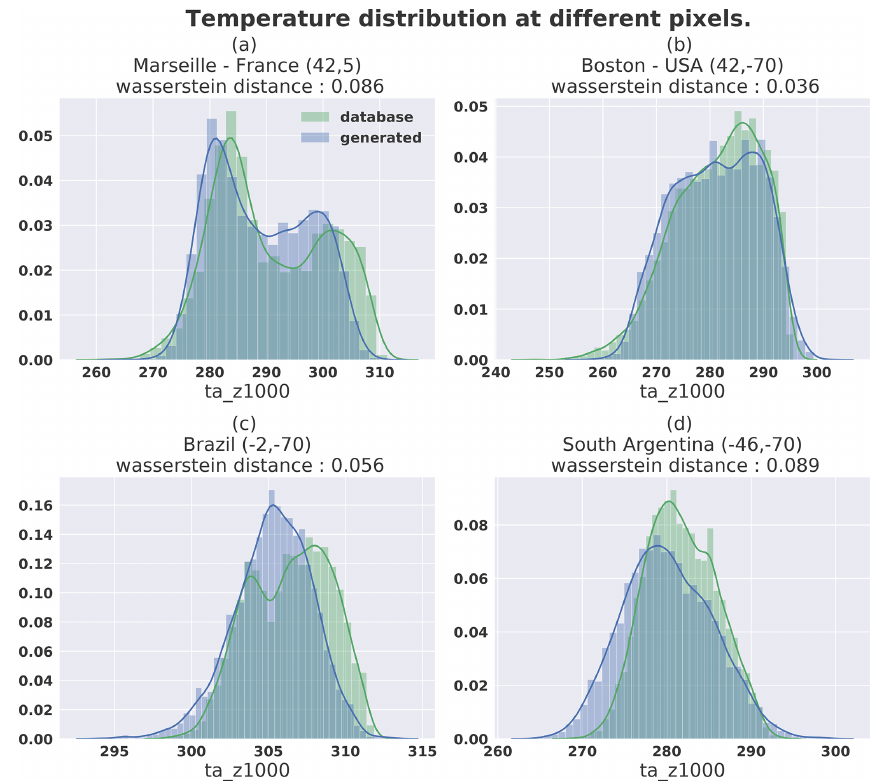
Figure 15. Temperature distribution at different locations for 5000 samples from dataset (green) and generated